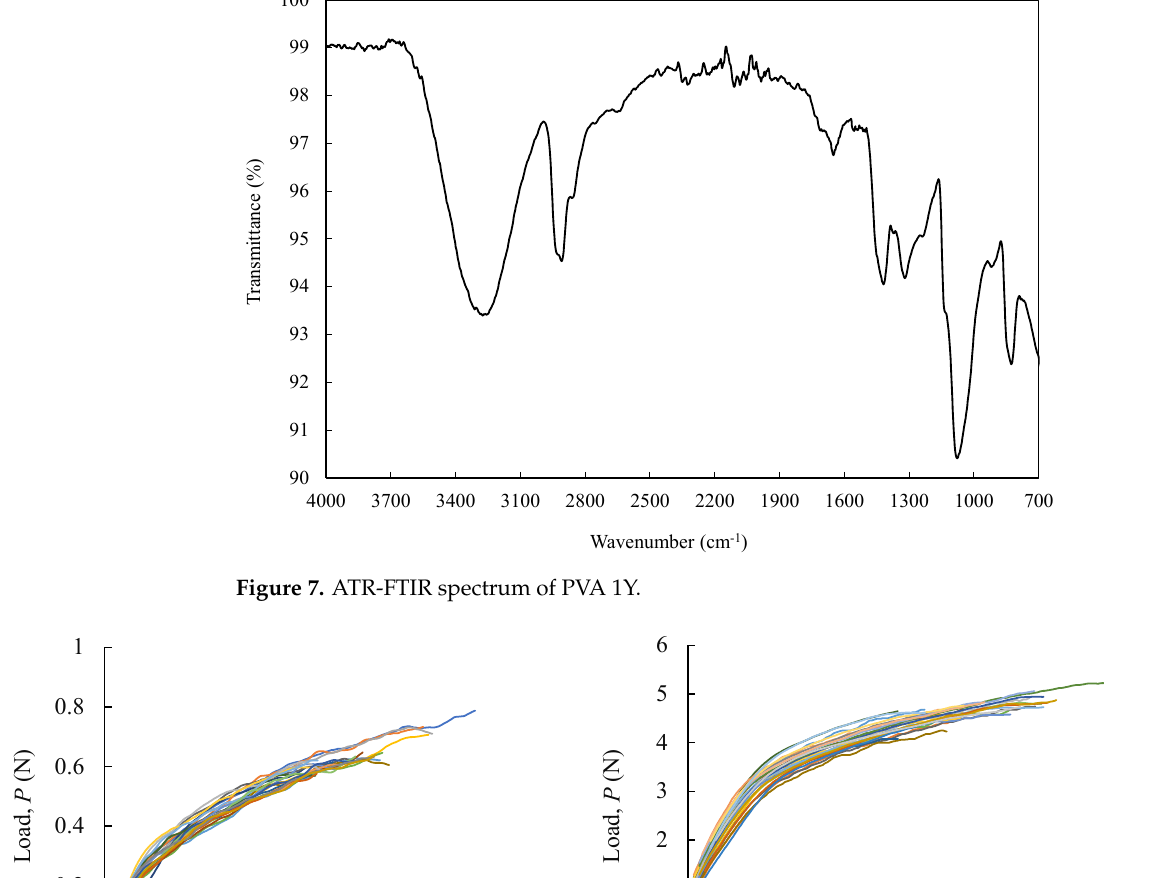
Figure 7. ATR-FTIR spectrum of PVA 1Y.